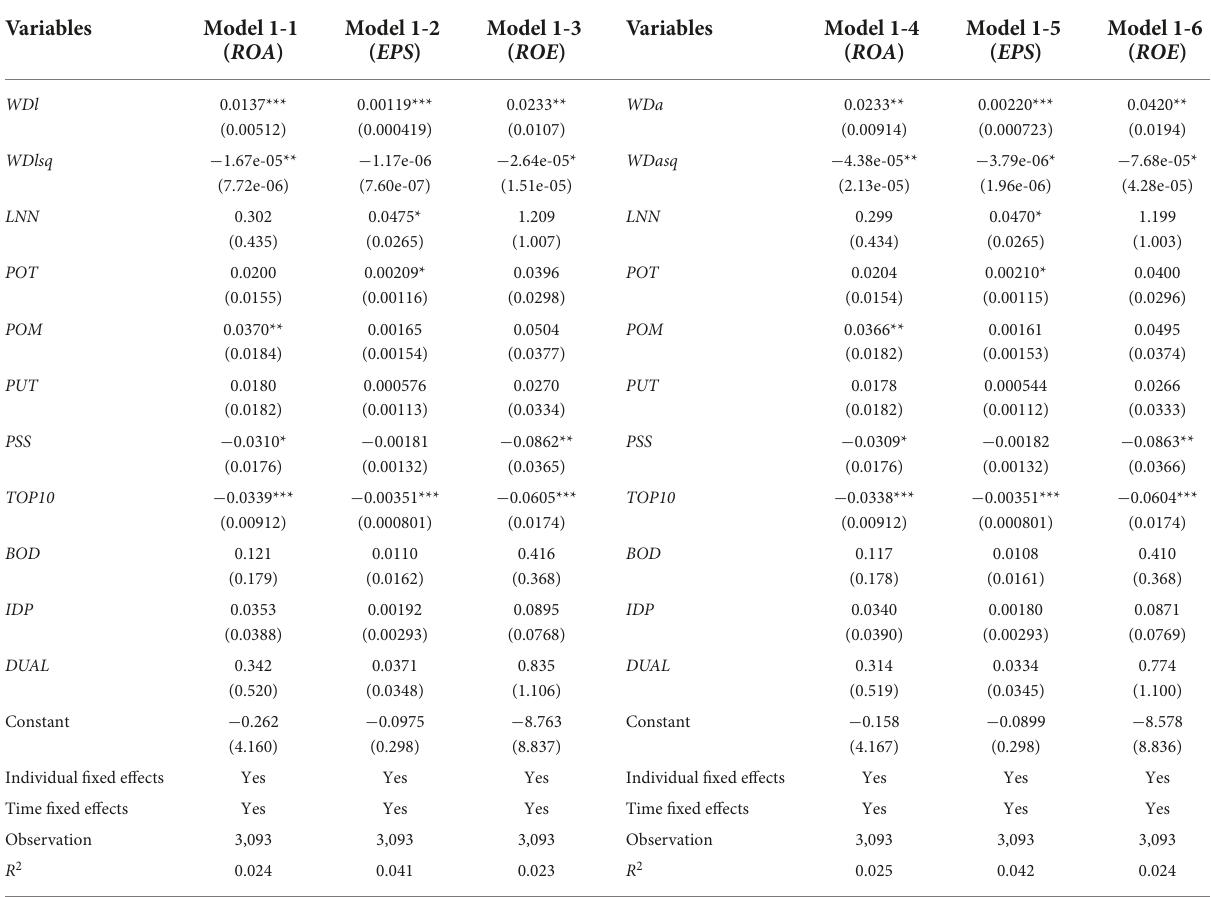
TABLE 4 Model 1 regression